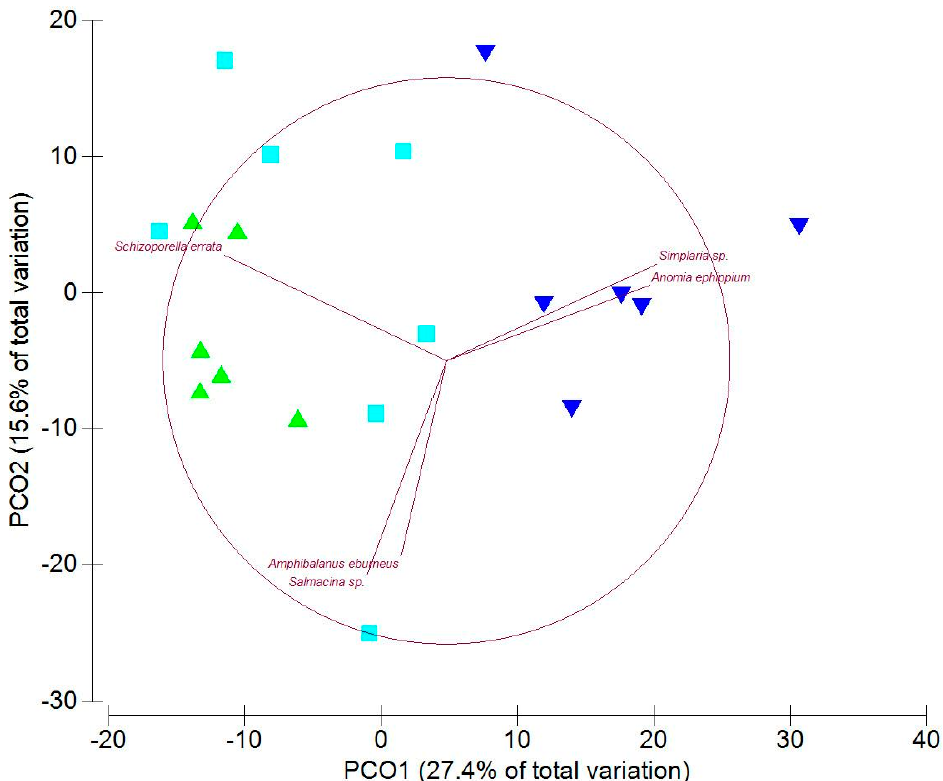
Figure 5. PCO on the Bray–Curtis similarity index (square root transformed data) among the panels of C, Ca and OCa treatment levels. Vectors of correlated taxa ( ≥ 0.7) are shown. C: control panels, (i.e., uncaged; green triangle); OCa: open-caged panels, (i.e., artifact control; blue triangle); Ca: caged panels (light blue square).